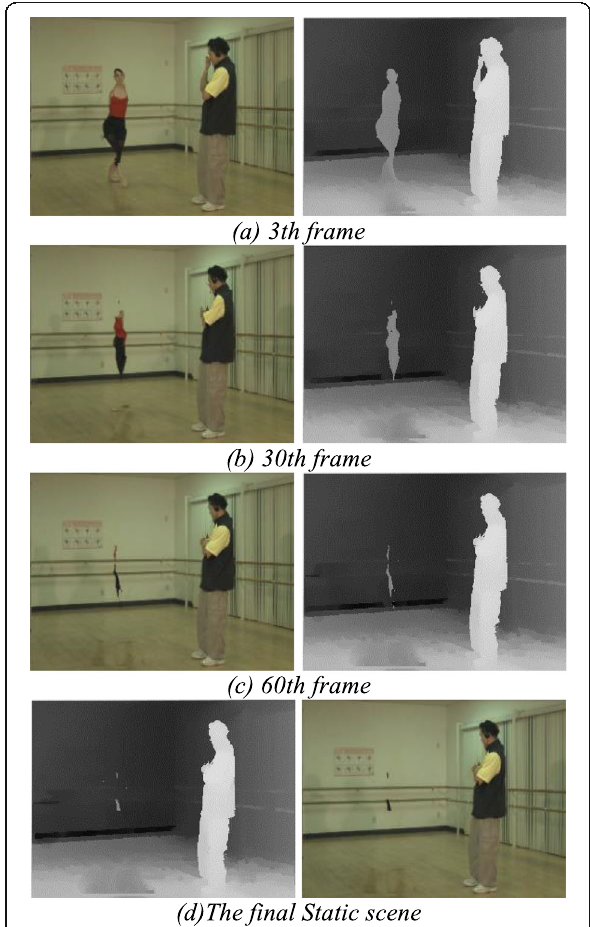
Fig. 4 Static scene extraction result of the “ Ballet ” sequence . a 3th frame. b 30th frame. c 60th frame. d The final static